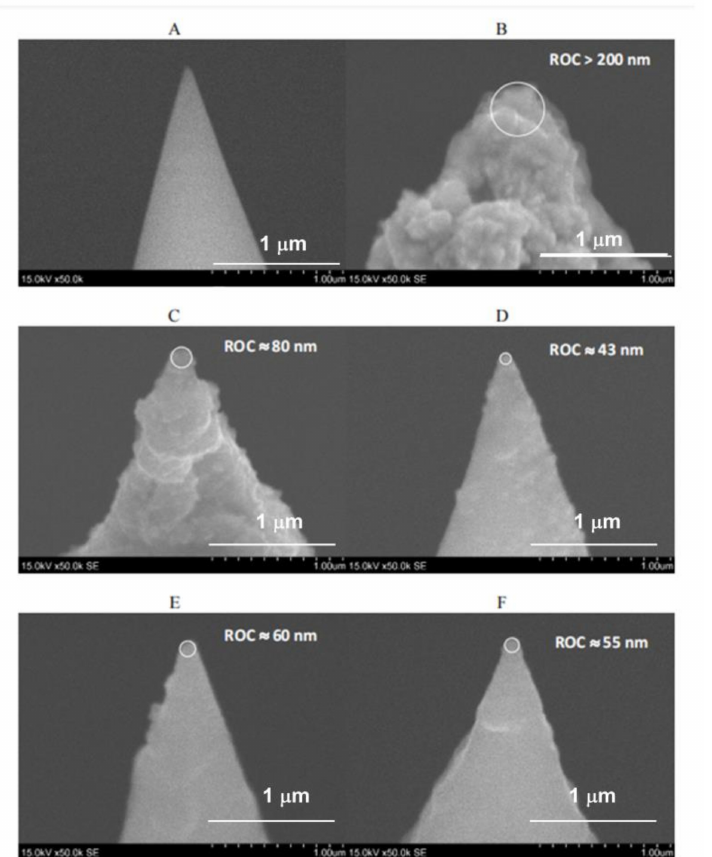
Figure 2. SEM images of uncoated Si tip ( A ) and Si tips, coated with Au for different electroless deposition times in an aqueous mixture of 1.0 mM HAuCl 4 and 2.0 mM H 2 OH 1:1): 3 min ( B ), 2 min ( C ) and 1 min (( D – F ), three separate samples). Magnification: 50,000